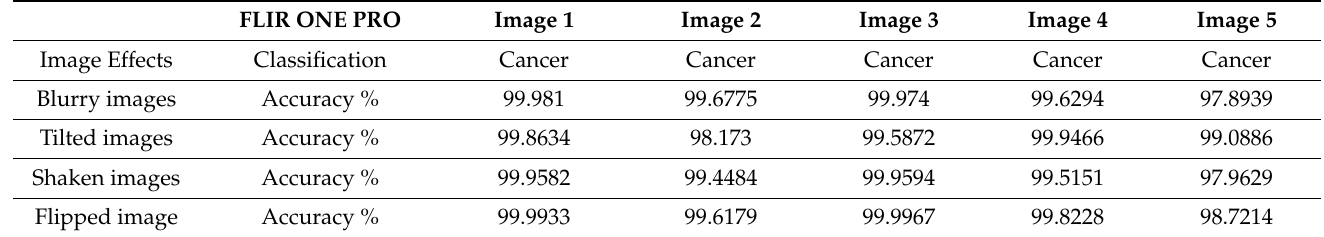
Table 7. Detection accuracy of thermal images (Flir one PRO) after